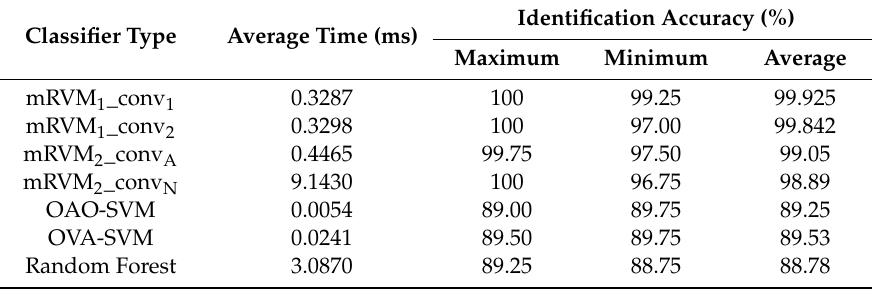
Table 7. Fault identification accuracy of di ff erent classifiers with the load 0